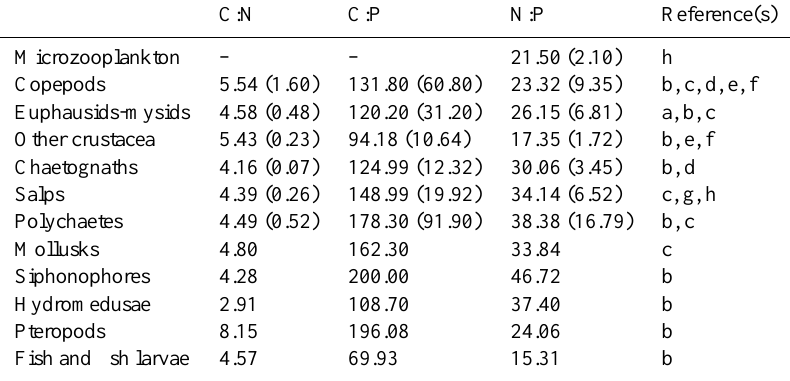
Table 4. Ecological C:N:P stoichiometry of various marine pelagic invertebrates and vertebrates (mean and standard deviation in brackets). C:N